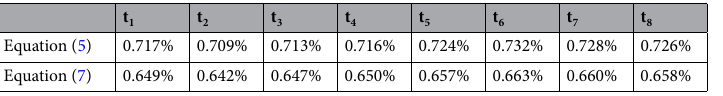
Table 4. Relative errors calculated by section of a pipe at the same representative time. The average relative errors at 8 time points are 0.721% for the original equation, Eq. (5), and 0.653% for the generalized equation, Eq. (7).